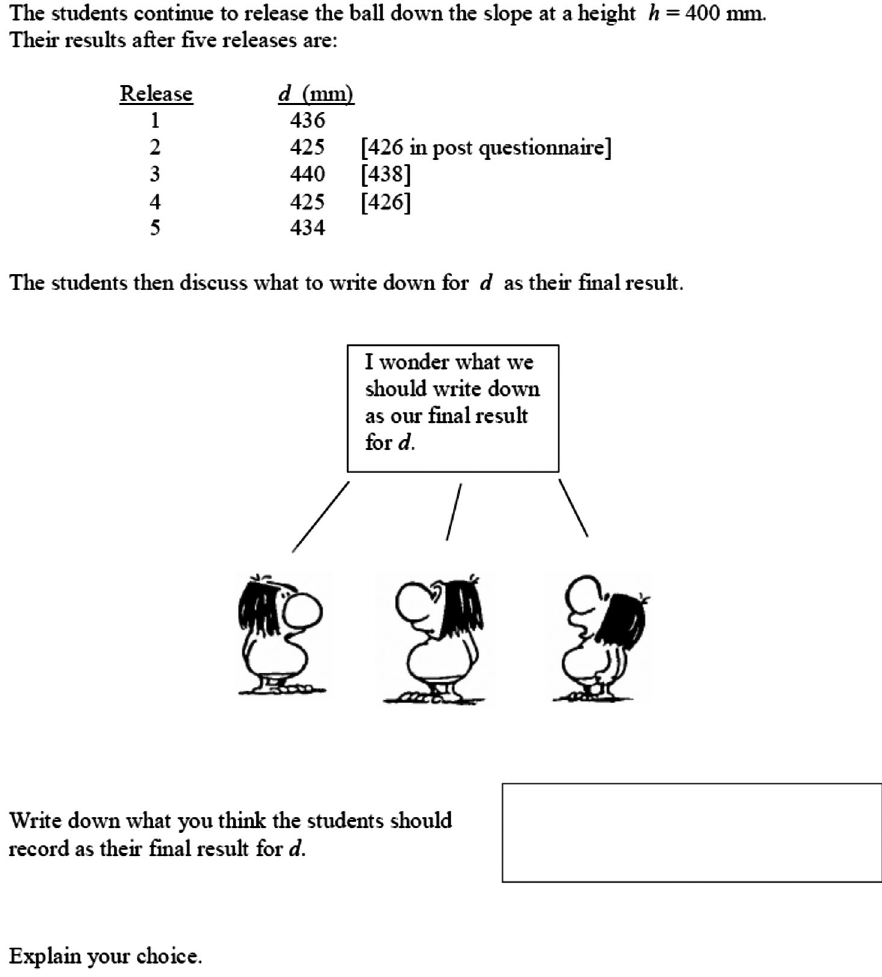
FIG. 9. The UR probe of the PMQ. Reproduced from Ref.